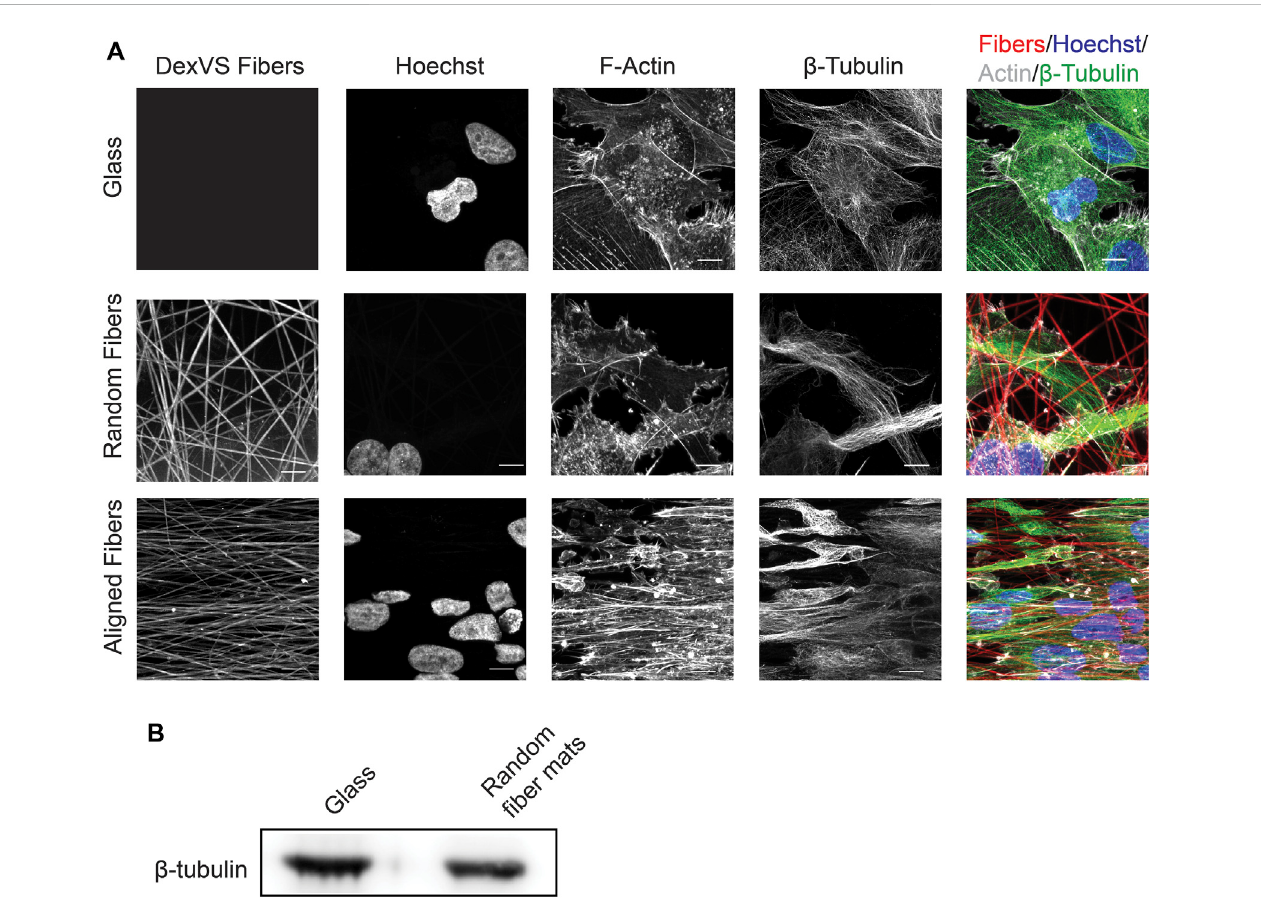
FIGURE 6 Expression and distribution of β -tubulin after cell migration on glass or fi ber mats. (A) Immuno fl uorescence localization of β -tubulin and F-actin after 24 h of cell migration on fi ber mats or glass. Scale bar is 10 μ m. (B) Immunoblot depicting β -tubulin expression after 6 days of cell migration on glass of random fi ber